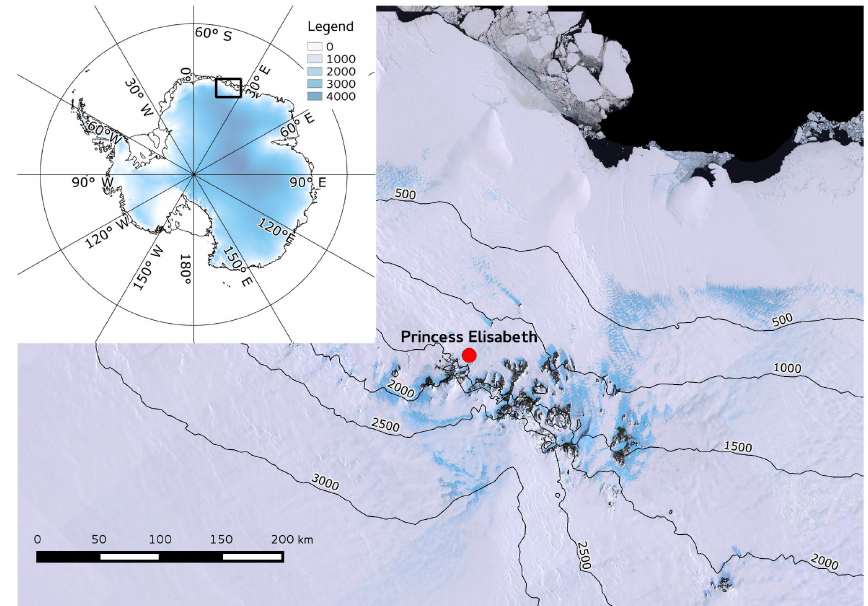
Figure 1. Location of the meteorological observatory at the Belgian Princess Elisabeth station, north of the Sør Rondane Mountains. Source: Landsat Image Mosaic of Antarctica (LIMA) Project, http://lima.usgs.gov/ (last access: 8 June 2018). Colours in the inset and contours on the main figure denote topography height